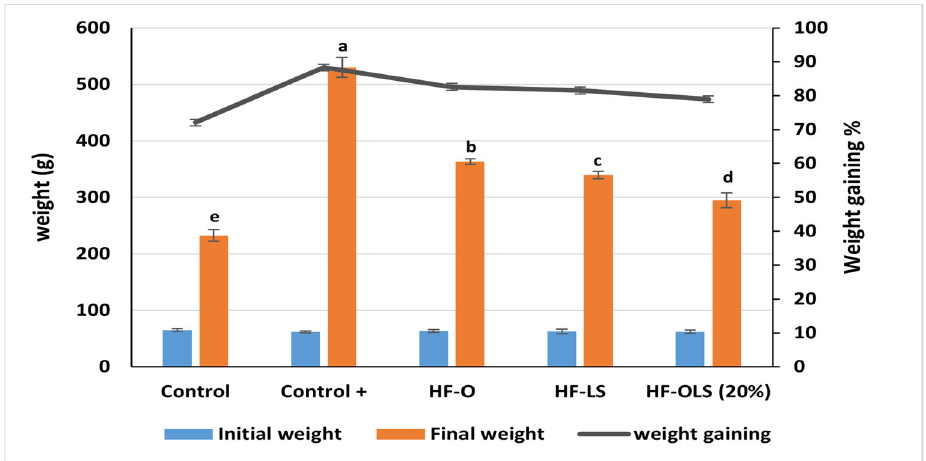
Figure 5. Initial weight, final weight, and weight gain of rats fed with standard diet, high fat diet, and a high fat diet and juice for three months. Control (Rats fed with a standard diet), Control+ (rats fed with a high ‐ fat diet composed by mixing standard diet with 20% of vegetarian ghee), HF ‐ O (rats fed with a high ‐ fat diet and 9 mL/kg/day of orange juice), HF ‐ LS (rats fed with a high ‐ fat diet and 9 mL/kg/day of beetroot leaf–stem juice), HF ‐ OLS (20%) (rats fed with a high ‐ fat diet and 9 mL/kg/day of orange juice mixed with 20% of beetroot leaf–stem juice). Columns of the final weight in feeding each group labeled with different letters are significantly different at p < 0.05.